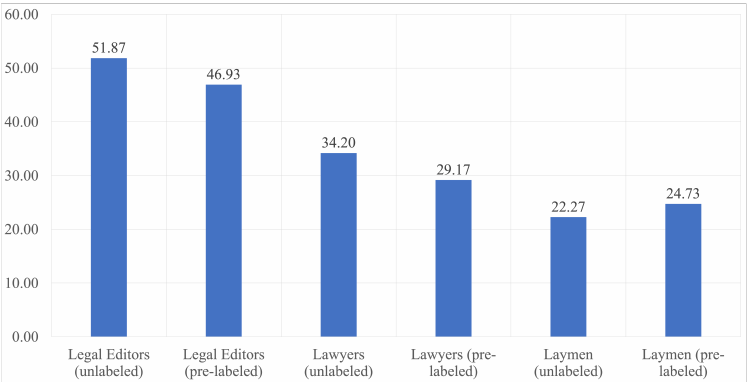
Figure 9. Percentage agreement between the 3 annotators (broken down into annotator